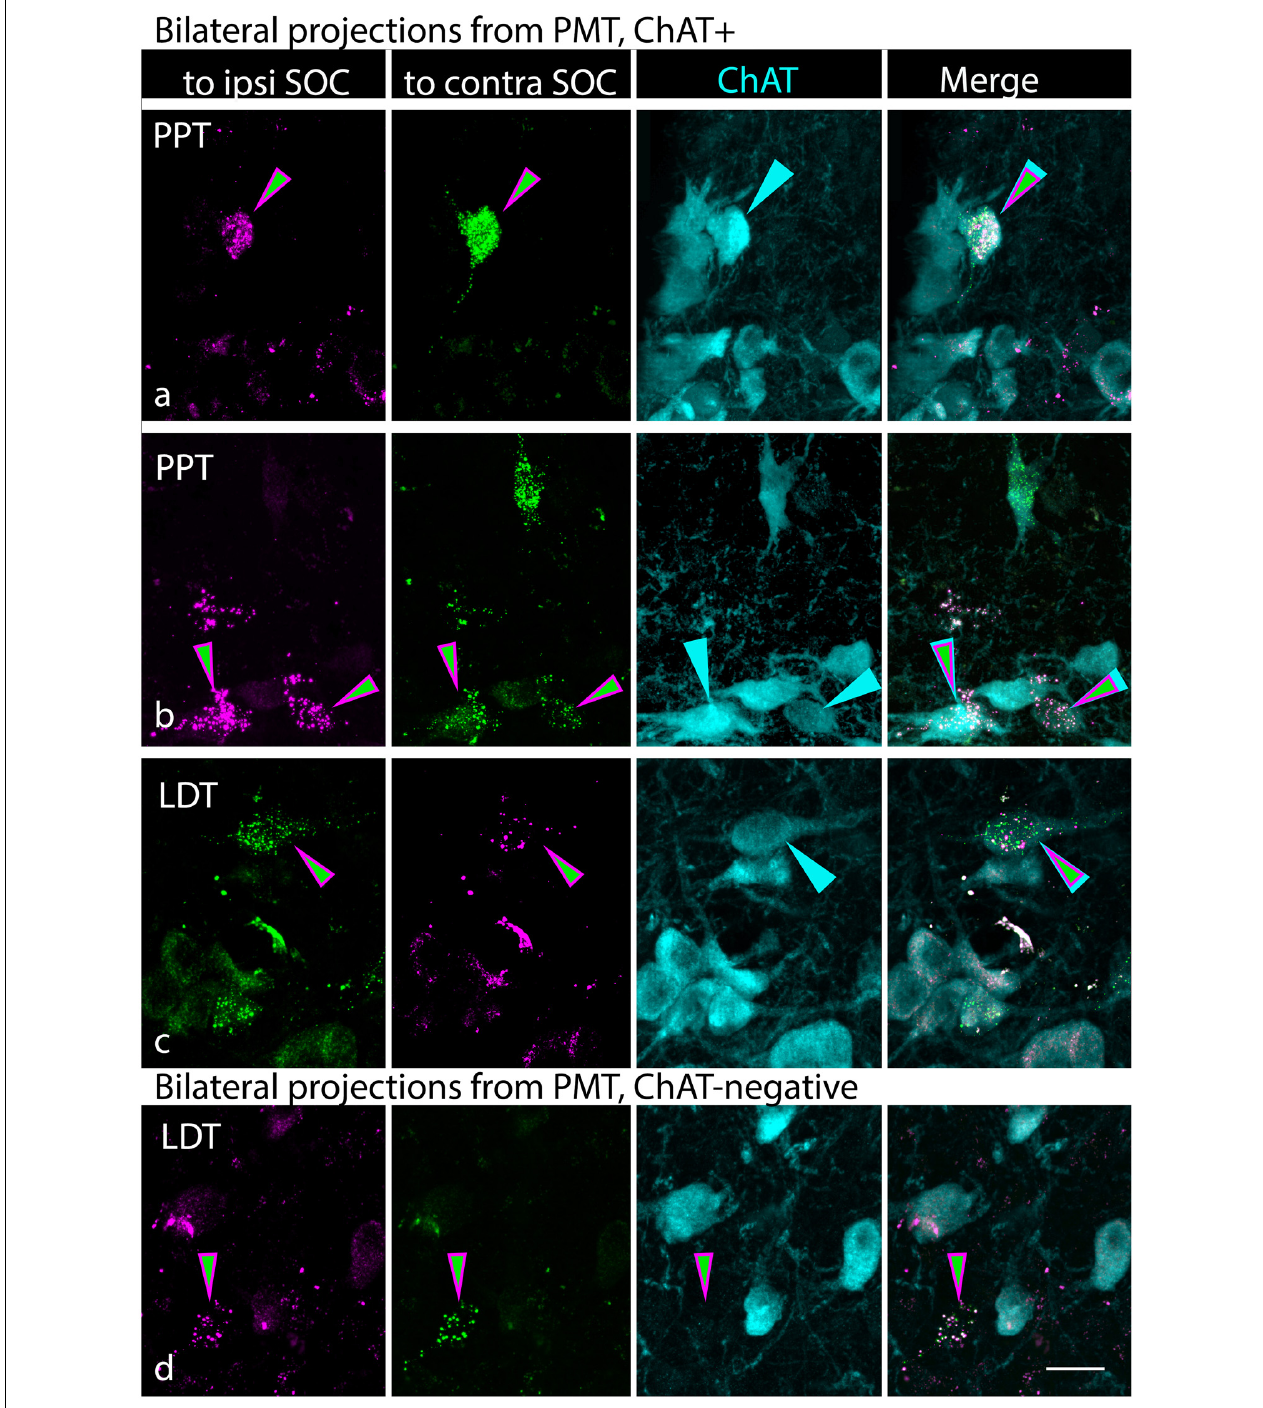
FIGURE 7 | Cholinergic and non-cholinergic cells in the PMT send branching axonal projections to innervate the SOC bilaterally. (A–C) Each row of photographs shows a single field of view. The first two columns show the tracer label (RB in magenta; GB in green), with the first column showing the tracer injected into the ipsilateral SOC and the second column showing the tracer injected into the contralateral SOC (relative to the labeled cells). Magenta/green arrows identify cells that contain both retrograde tracers. Column 3 shows the ChAT staining, with arrows pointing to the same cells as in the first two columns. Column 4 shows the images merged, highlighting the triple-labeled cells. Examples are from the PPT (A,B) and LDT (C) . (D) A single cell in the LDT that contains both retrograde tracers, indicating a bilateral projection to the SOC, but is ChAT-negative (column 3), indicating it is unlikely to be cholinergic. All panels from case G18-2012. Scale bar = 20 µ